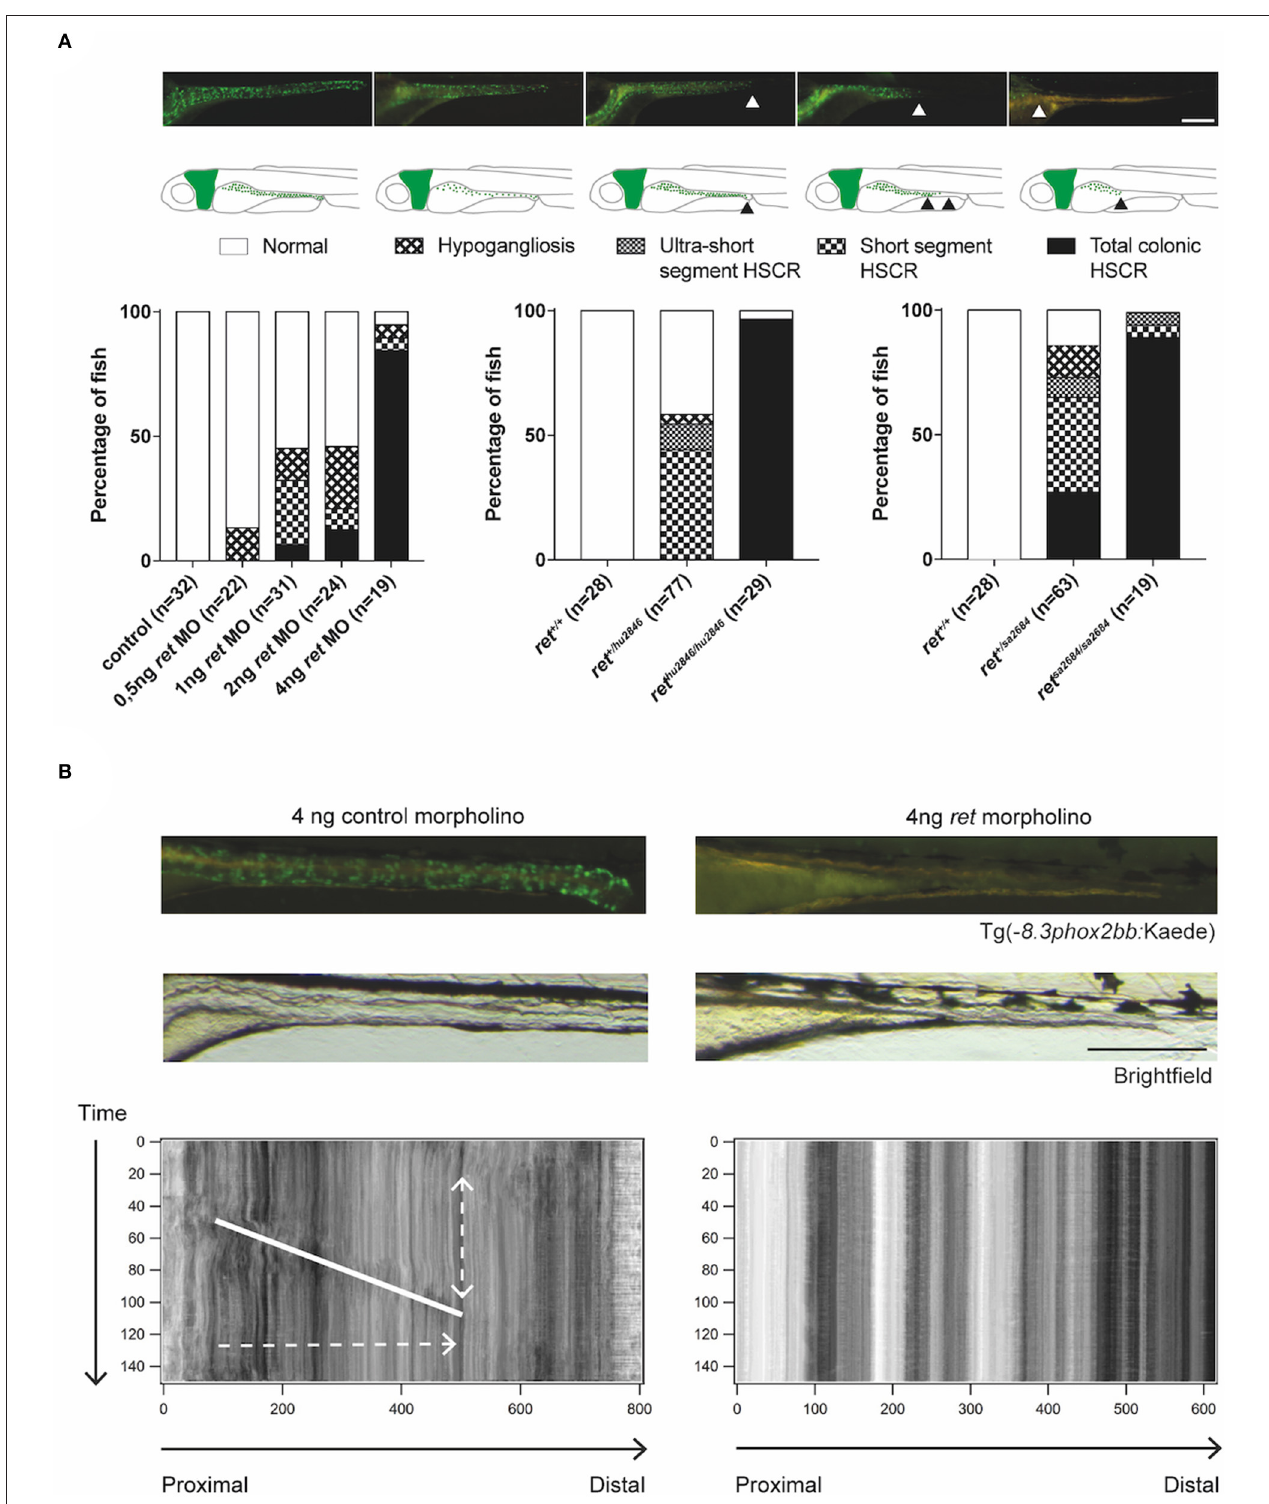
FIGURE 3 | Functional analysis of ret morphants and mutants. (A) Phenotypical variability observed in zebrafish, using MO targeting Ret expression and two different zebrafish ret mutant lines. Proposed phenotyping classifications are shown by microscopy images and illustrations. Scale bar represents 200 µ m. (B)